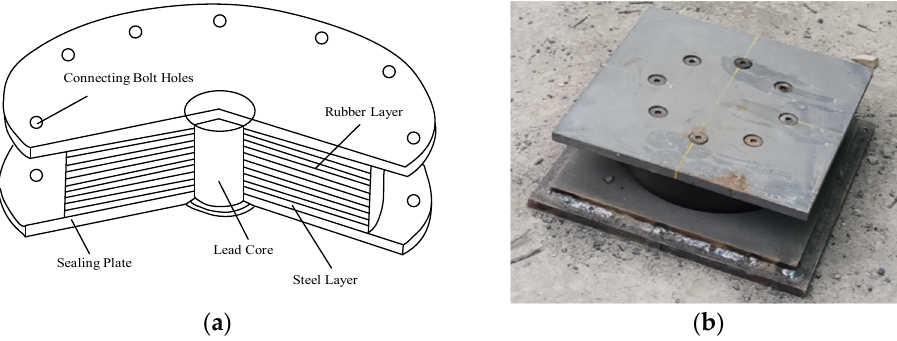
Figure 2. Dimensions of the test tank model: ( a ) Model diagram of lead-core vibration isolation rubber bearing; ( b ) Physical map of lead rubber bearing.